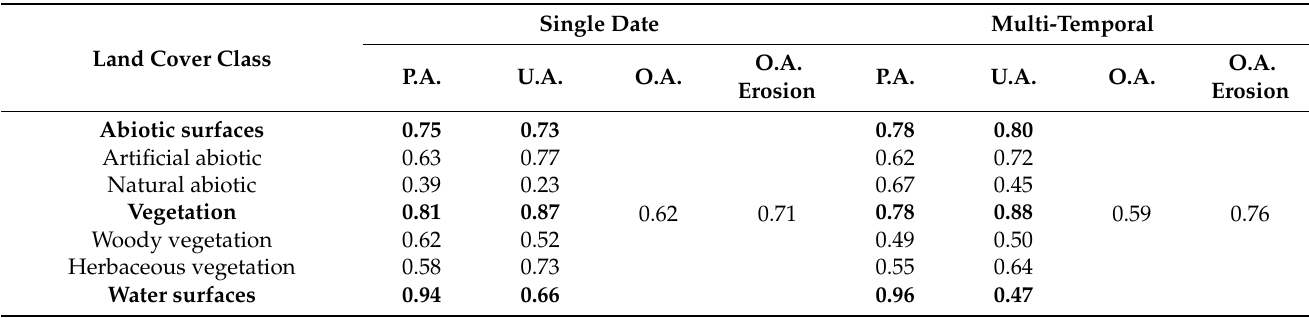
Figure 6. Single-date land cover map of Rome (LCR) produced by classifying the 10-band single-date Sentinel-2 data of July the 25 with the VGG16 algorithm. Table 5. Accuracy assessment of the LCR. The results in single dates refer to the classification based on the summer image of 25 July 2019. P.A. = Producer Accuracy, U.A. = User Accuracy, O.A. = Overall